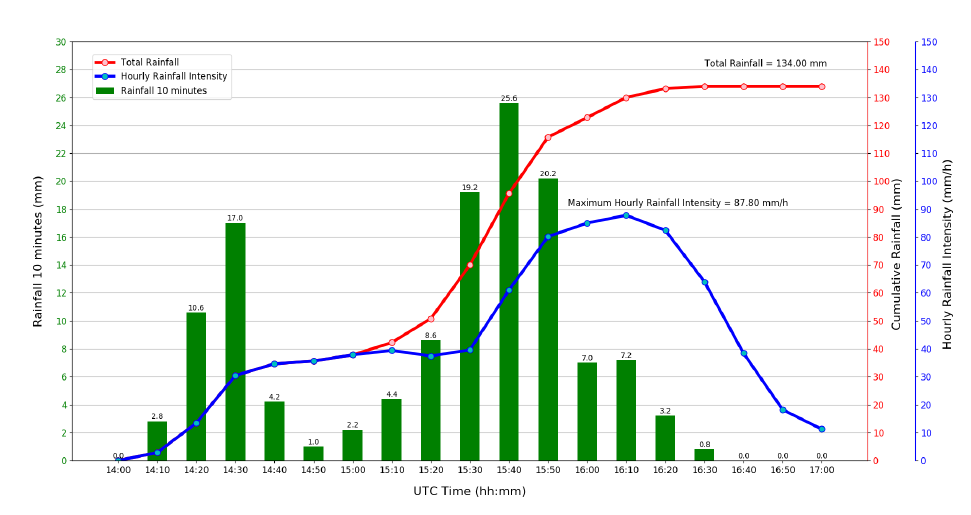
Figure 18. Rainfall accumulations, reported along intervals of 10 min, detected by the Palermo weather station belonging to the Servizio Informativo Agrometeorologico Siciliano